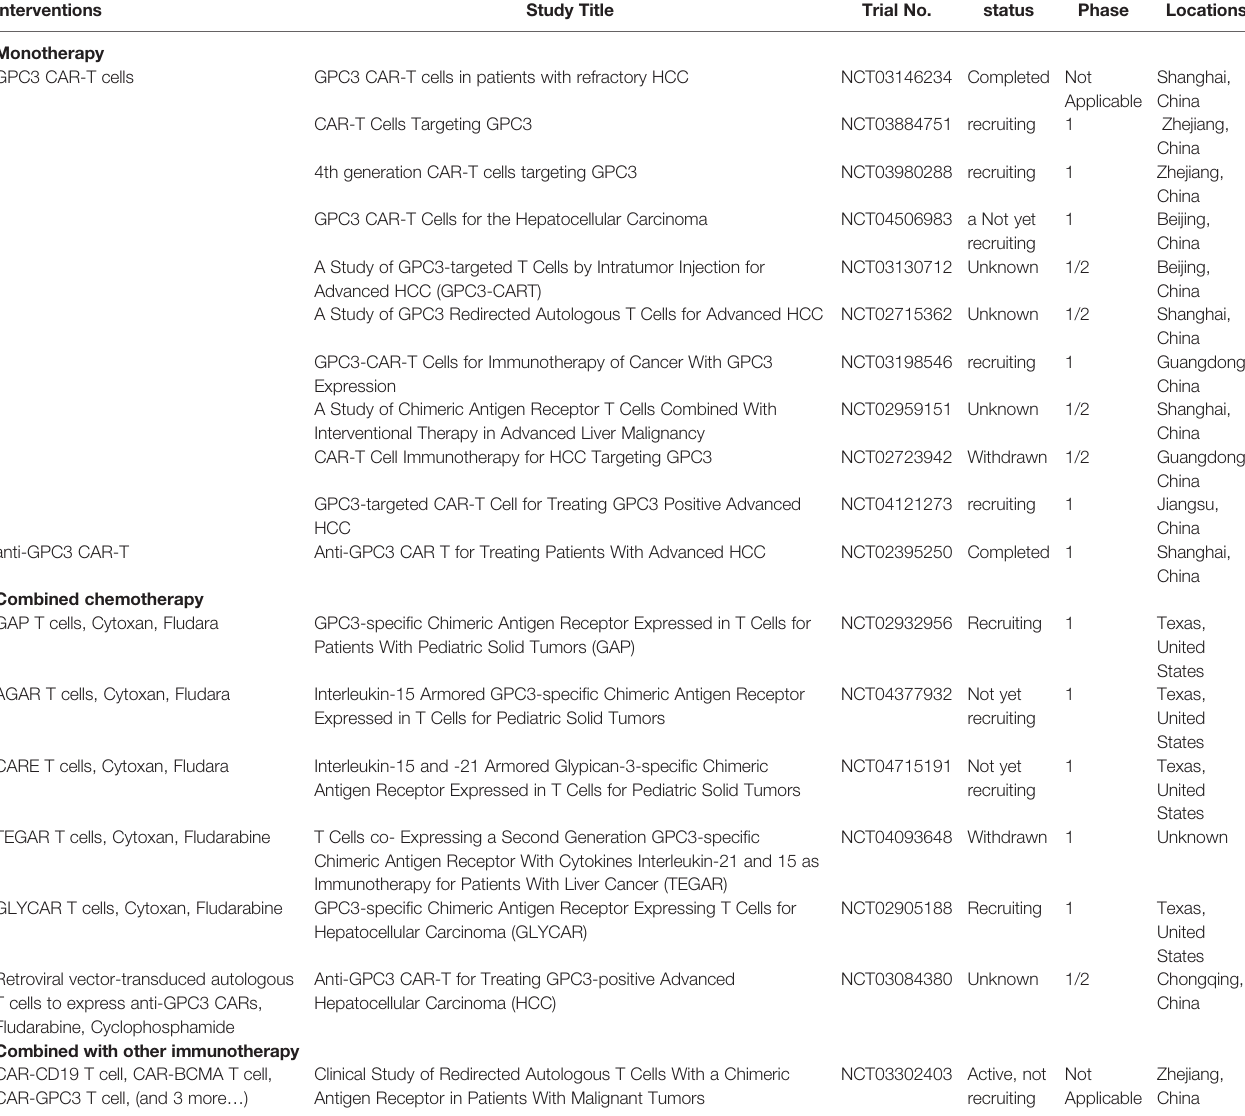
TABLE 1 | Clinical trials of GPC3-CAR-T for treating liver cancer.